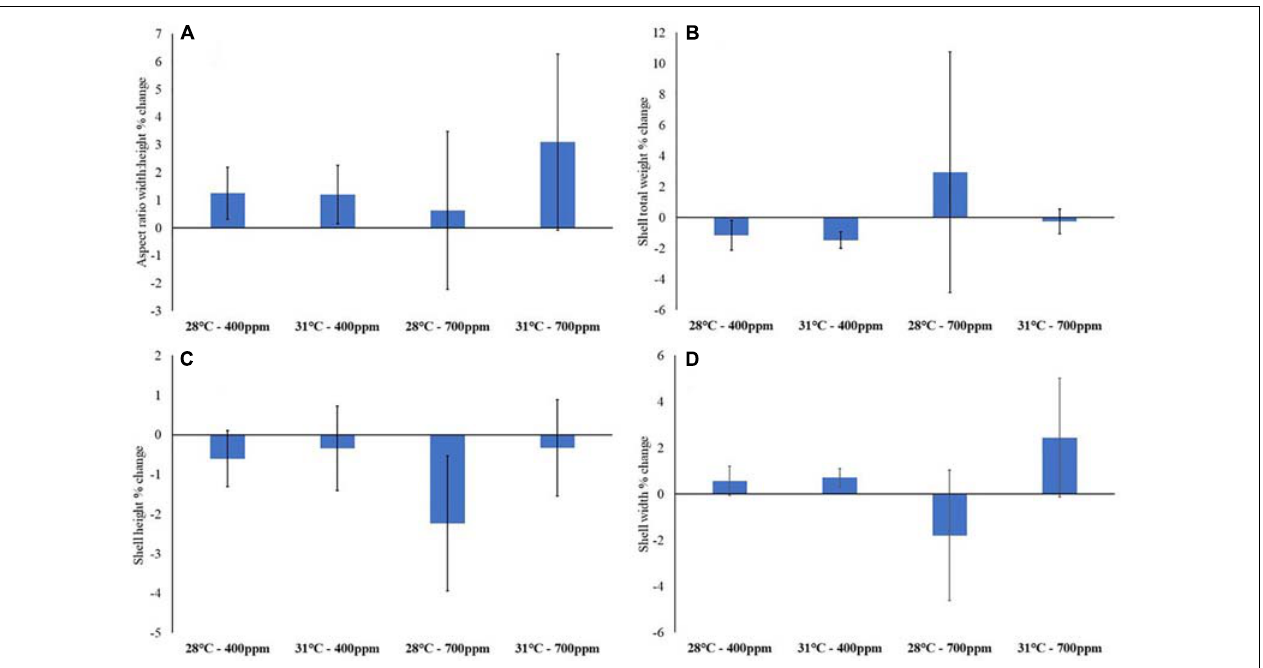
FIGURE 3 | Gastropod biometrics after 12-weeks exposure to control conditions (28 ◦ C, 400 ppm), high temperature (31 ◦ C, 400 ppm), high CO 2 (28 ◦ C, 700 ppm) and a combination of both high temperature and CO 2 (31 ◦ C, 700 ppm). (A) Aspect ratio (width: height); (B) total weight (g); (C) shell height; and (D) shell width (mm) ( n = 15). Values are percentage change from prior to exposure to experimental conditions ± standard error.